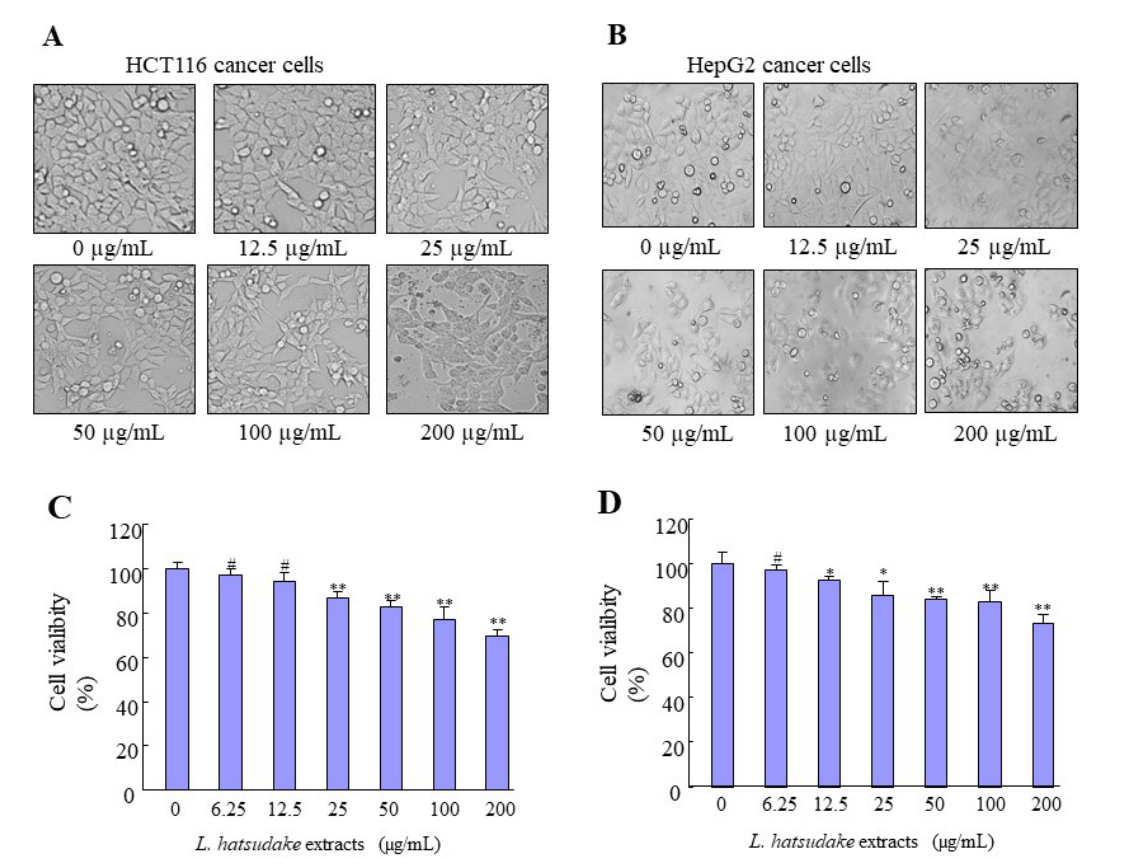
Figure 3. The effect of L. hatsudake extracts on the cell morphology proliferation of HCT116 and HepG2 cancer cells. ( A ) The cell morphology of HCT116 cells. ( B ) The cell morphology of HepG2 cells. ( C ) The cell viability of HCT116 cells by MTS analysis. ( D ) The cell viability of HepG2 cells by MTS analysis. *: p < 0.05; **: p < 0.01; #: p > 0.05.